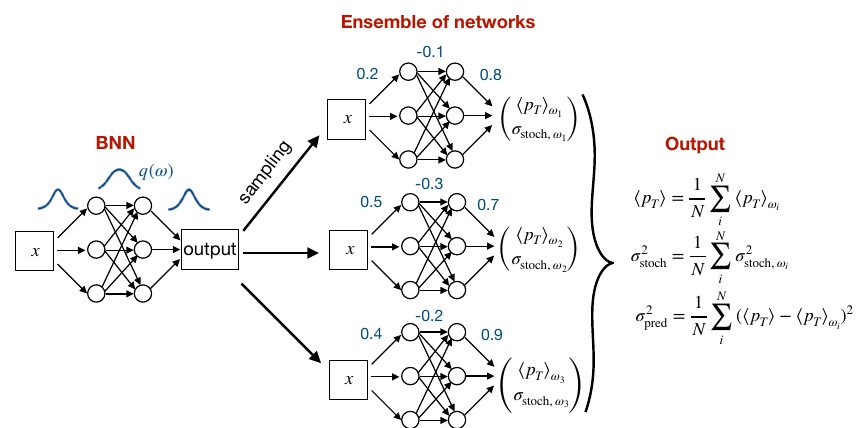
Figure 1: Illustration of our Bayesian network setup. The Bayesian network provides us with an uncertainty estimate for a single input jet x